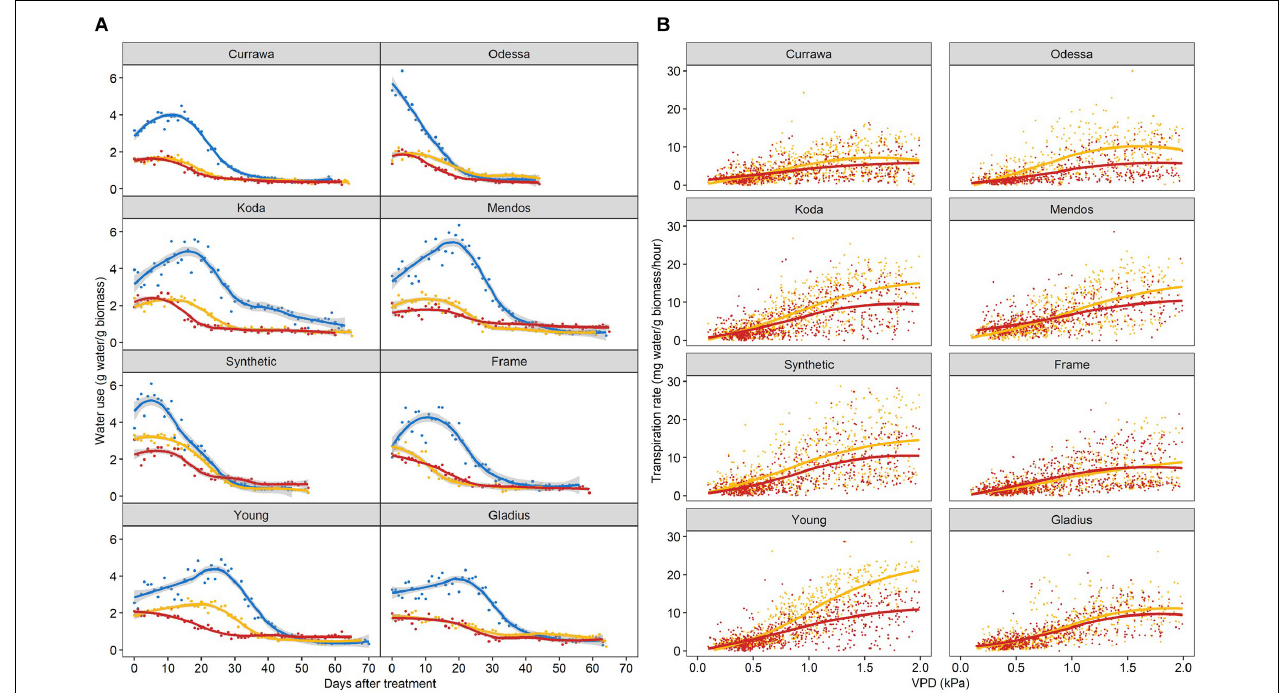
FIGURE 5 | Interaction of high temperature and drought differentially reduced daily water use and transpiration response to vapor pressure deficit. (A) Daily water use per plant estimated as total irrigation per day, normalized to aboveground biomass. Plants grown in well-watered conditions (blue), drought (orange), or in drought following 3-day heat stress (red). 0 DAT is the first day post-heat treatment (12 days after anthesis). Trend lines are loess regressions. Values are means of four replicates ( n = 4). The confidence interval (0.95) is displayed around smoothed regressions in gray. (B) Hourly transpiration rate response to VPD normalized to aboveground biomass. Plants grown in drought (orange) or in drought following 3-day heat stress (red). Graphs include data from 0 to 30 DAT. Trend lines are smooth regression lines.